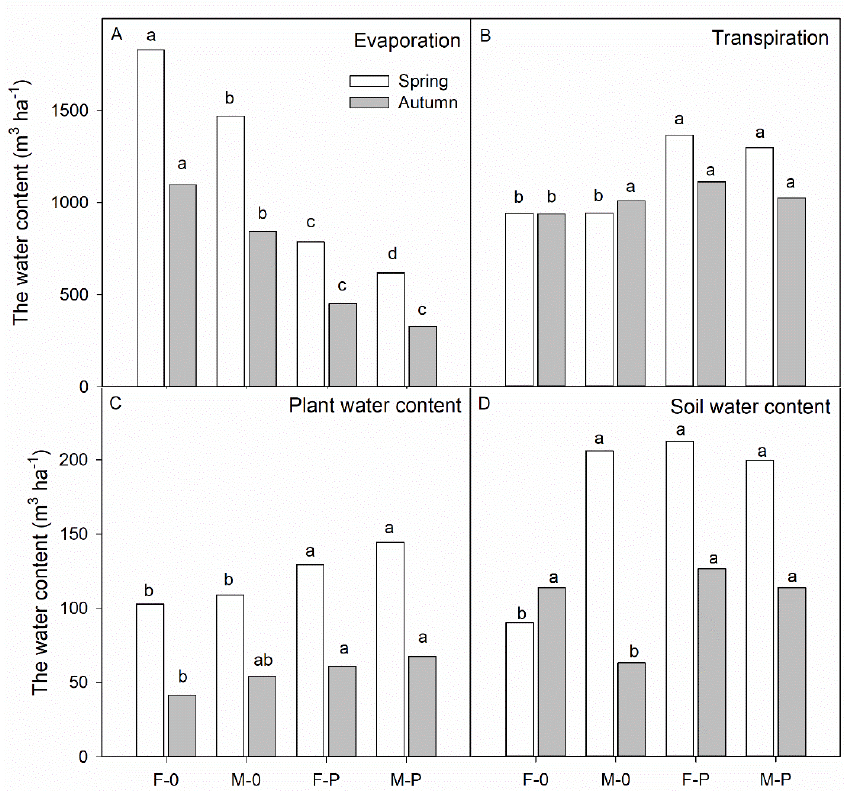
Figure 3. The irrigation water distribution under di ff erent water management techniques in spring and autumn seasons. ( A ): the sum of evaporation amount during the two growing seasons; ( B ): the sum of transpiration during the two growing seasons; ( C ): the plant water content at harvest; ( D ): the soil water content at harvest time. F-0, M-0, F-P, and M-P were abbreviations for furrow irrigation, micro-irrigation, furrow irrigation with plastic mulch, and micro-irrigation with plastic mulch. The di ff erent lower-case letters indicate the significant di ff erence among water management techniques in each season at p < 0.05 ( n = 3).